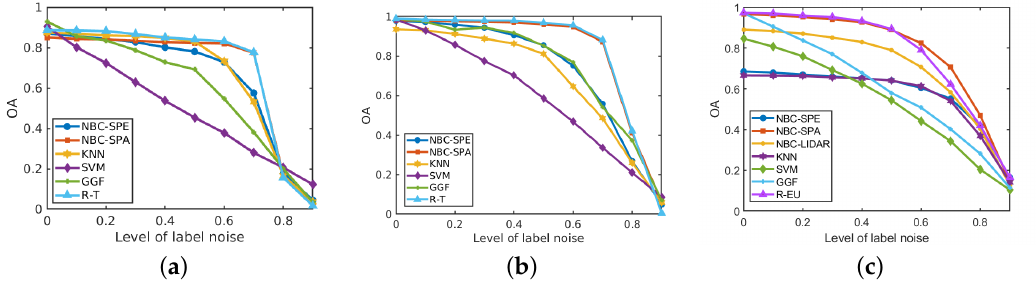
Figure 16. Influence of label noise on the performance (in terms of OA) of different methods on three data sets. ( a ) HYDICE Urban ; ( b ) Salinas Scene ; ( c ) GRSS2013